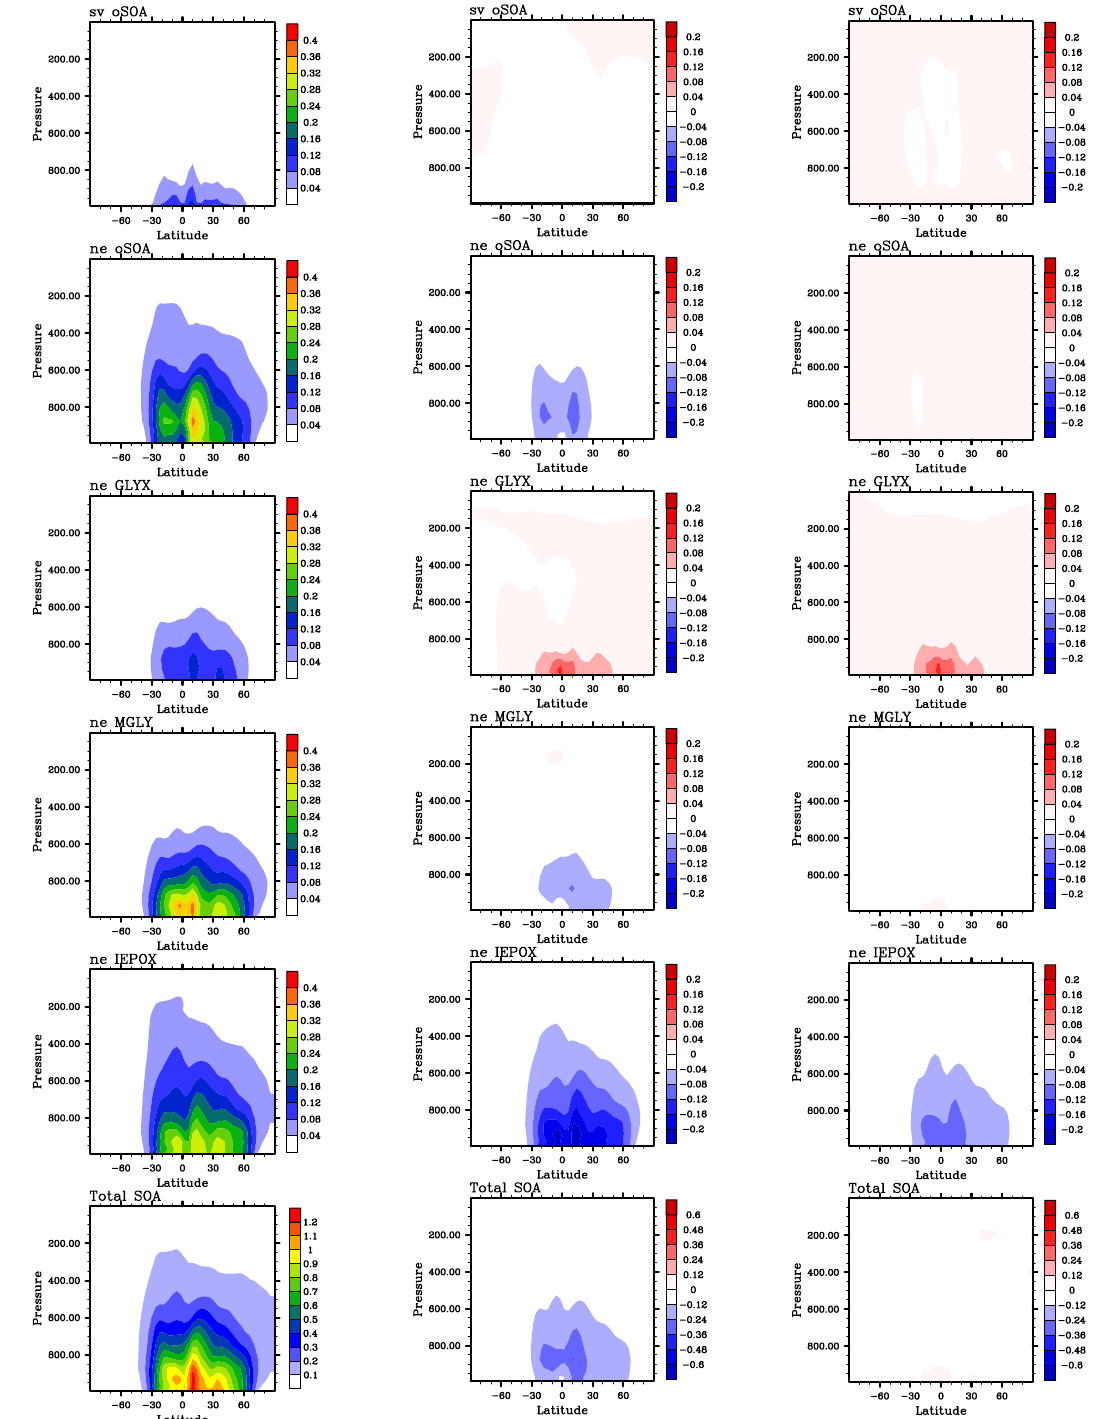
Fig. 3. Annual zonal mean simulated SOA concentrations in Simulation A (first column) and the changes in vertical distributions of SOA concentrations from Simulation A after including the new HO x recycling mechanism (Simulation B–Simulation A) in the second column, and reducing the reaction rates of 1,5-H and 1,6-H shifts by a factor 10 (Simulation C–Simulation A) in the third column for each SOA component (the first 5 rows) and the total SOA (the sixth row). The maximum and minimum values for color scales in the second and third column are set to half the maximum values of those in the first column (Simulation A). Units: µgm − 3